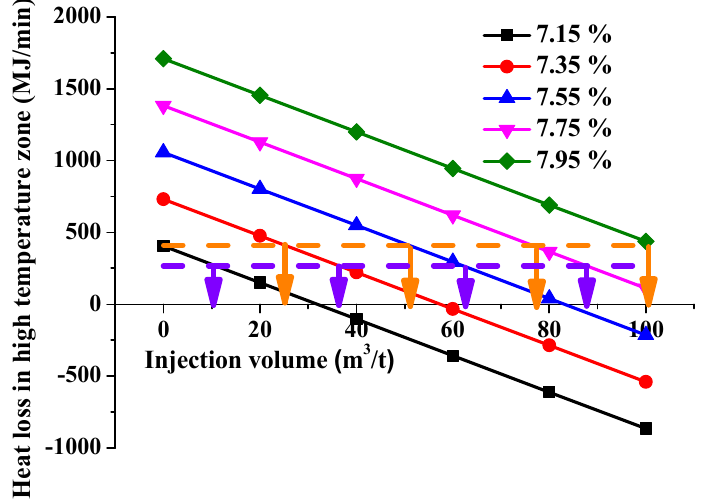
Figure 13. Effect of NG injection on heat loss in the high temperature zone of blast furnace under different oxygen enrichment rates.